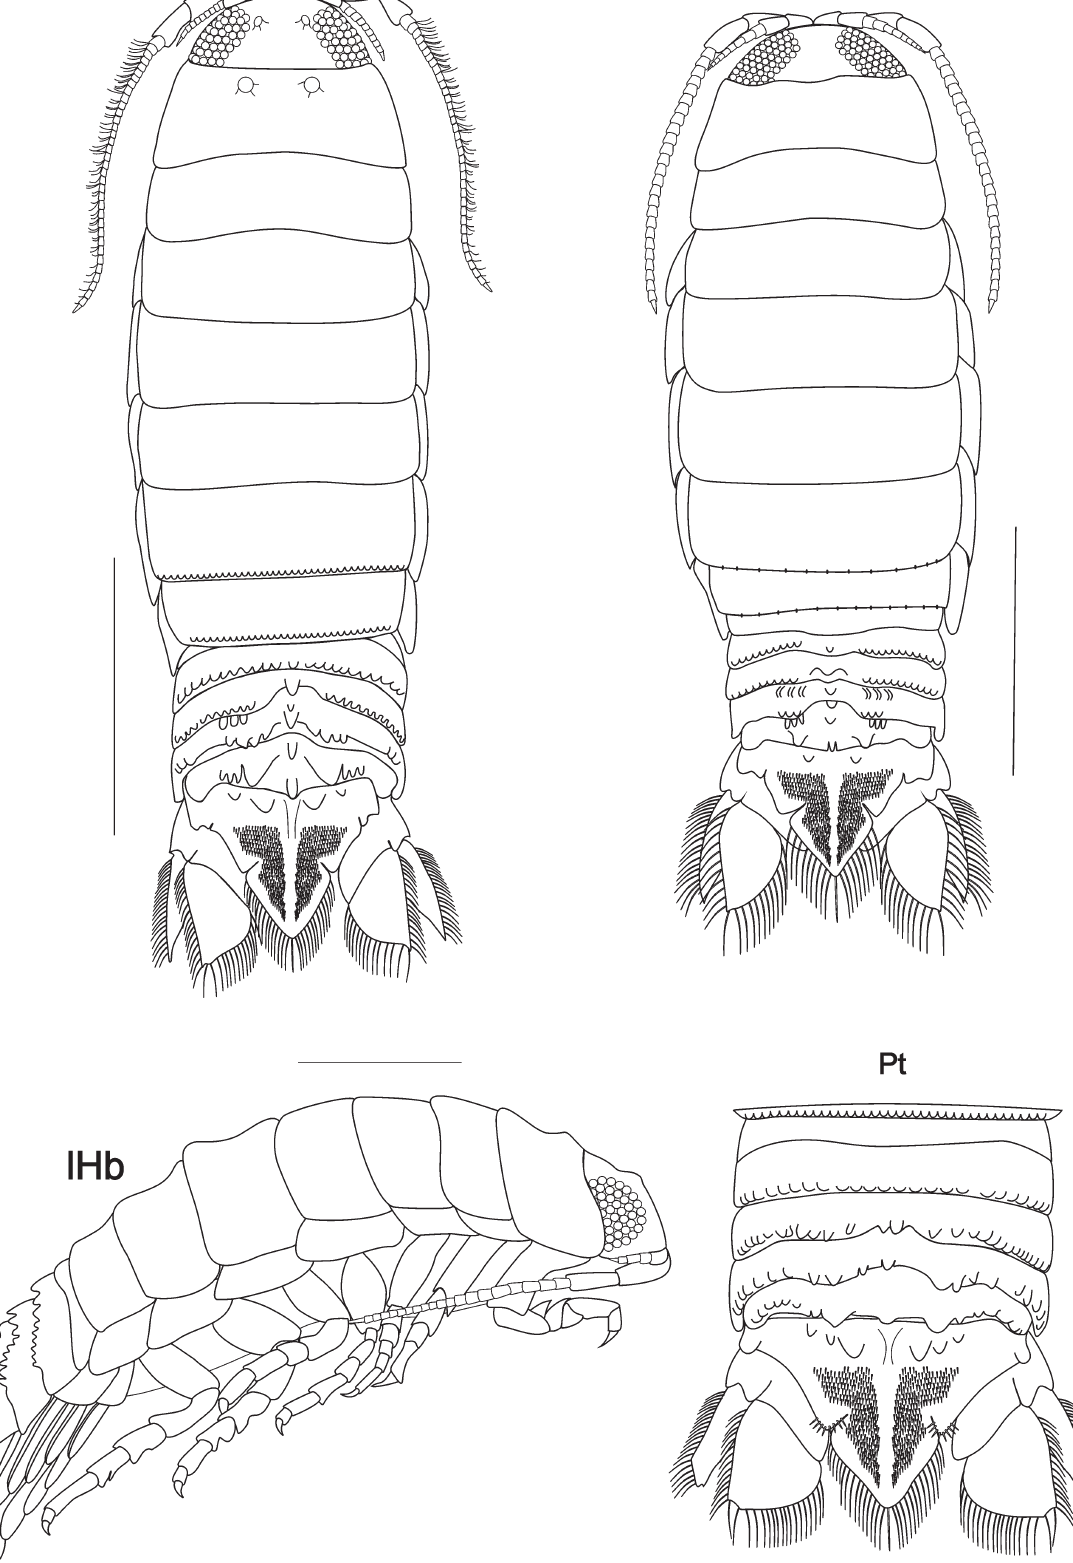
Figure 1. Excorallana bicornis Lemos de Castro and Lima, 1971. (MOUFPE 874), habitus of male and female. Scale = 5 mm. (MOUFPE 870), lateral view of female with variation. (MOUFPE 876), pleotelson of female with variation. Scales = 2